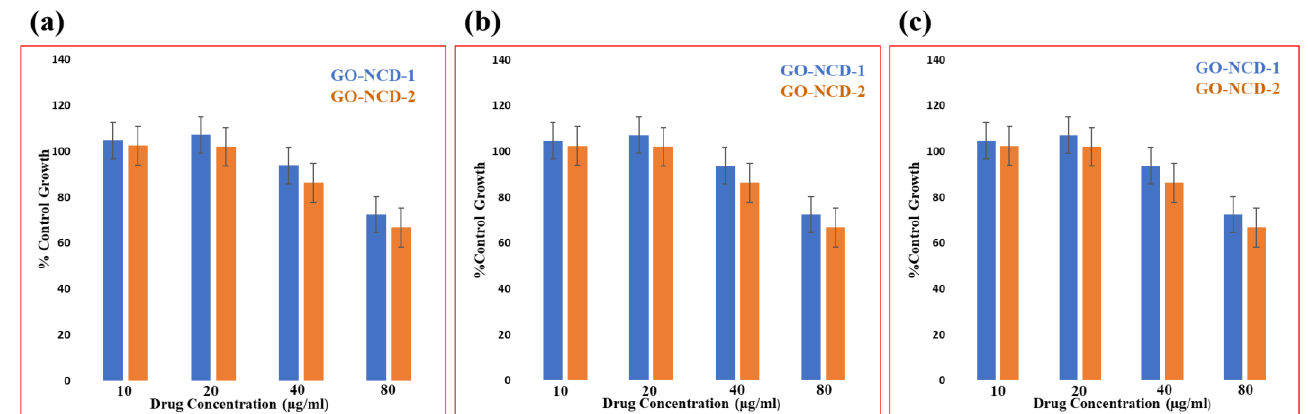
Figure 17. In vitro antitumor activity of GO-NCD- 1 and GO-NCD- 2 against ( a ) Human breast cancer cell line, MCF-7 ( b ) Human breast cancer cell line, MDA-MB-231 ( c ) Human cervical cancer cell line, HeLa.